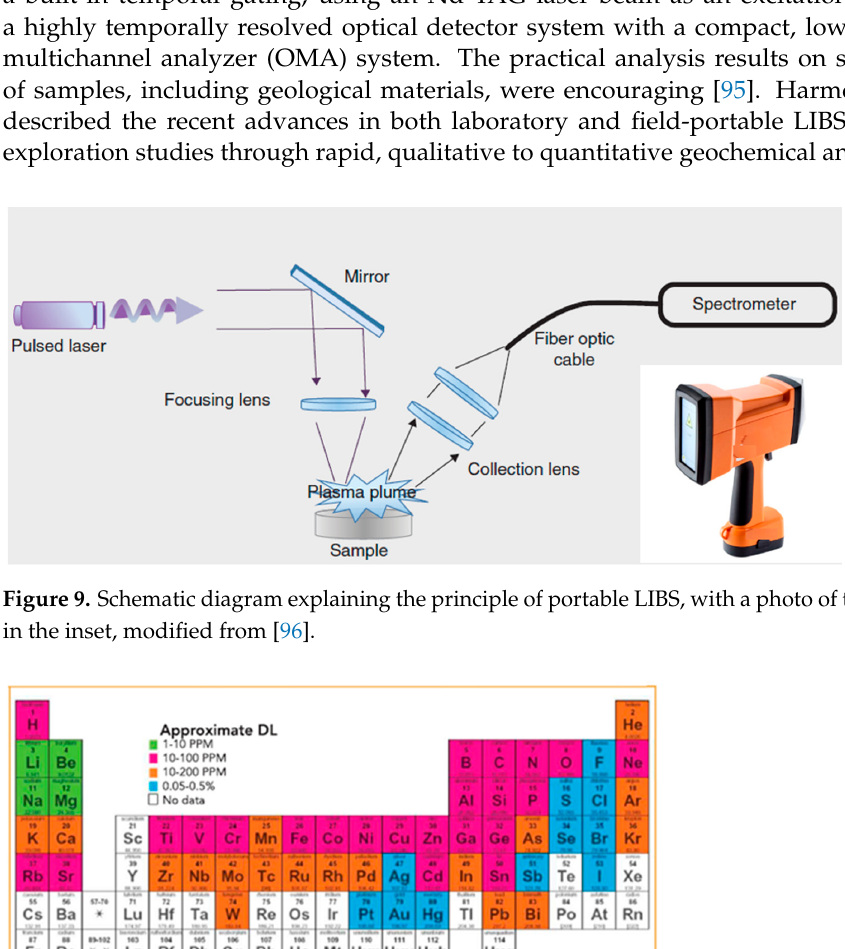
Figure 11. LIBS spectra in the entire wavelength range obtained from different Li-rich minerals [22].